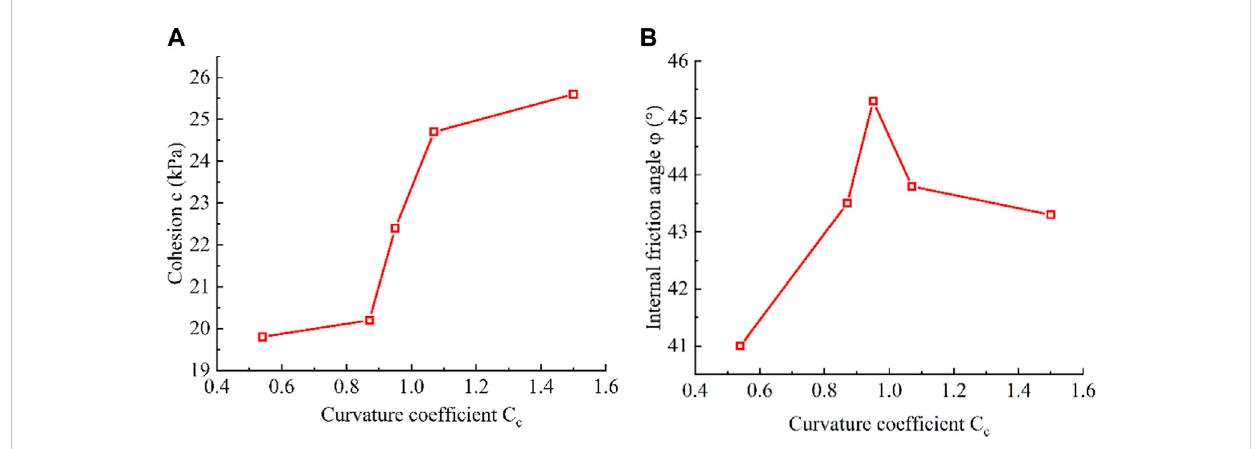
FIGURE 7 Relationship between Cc and cohesion and the internal friction angle. (A) Relationship between Cc and cohesion. (B) Relationship between Cc and the internal friction angle.